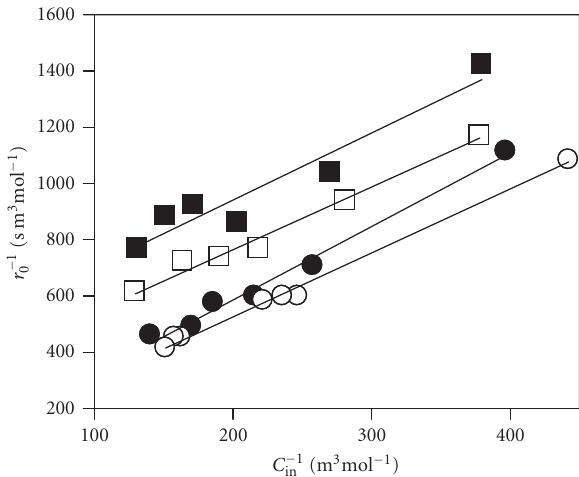
Figure 3: Reciprocal PCO reaction rates on TiO 2 versus the recip- rocal DMA initial concentrations at ( (cid:2) ) 353, ( (cid:3) ) 373, ( • ) 393, and ( ◦ )